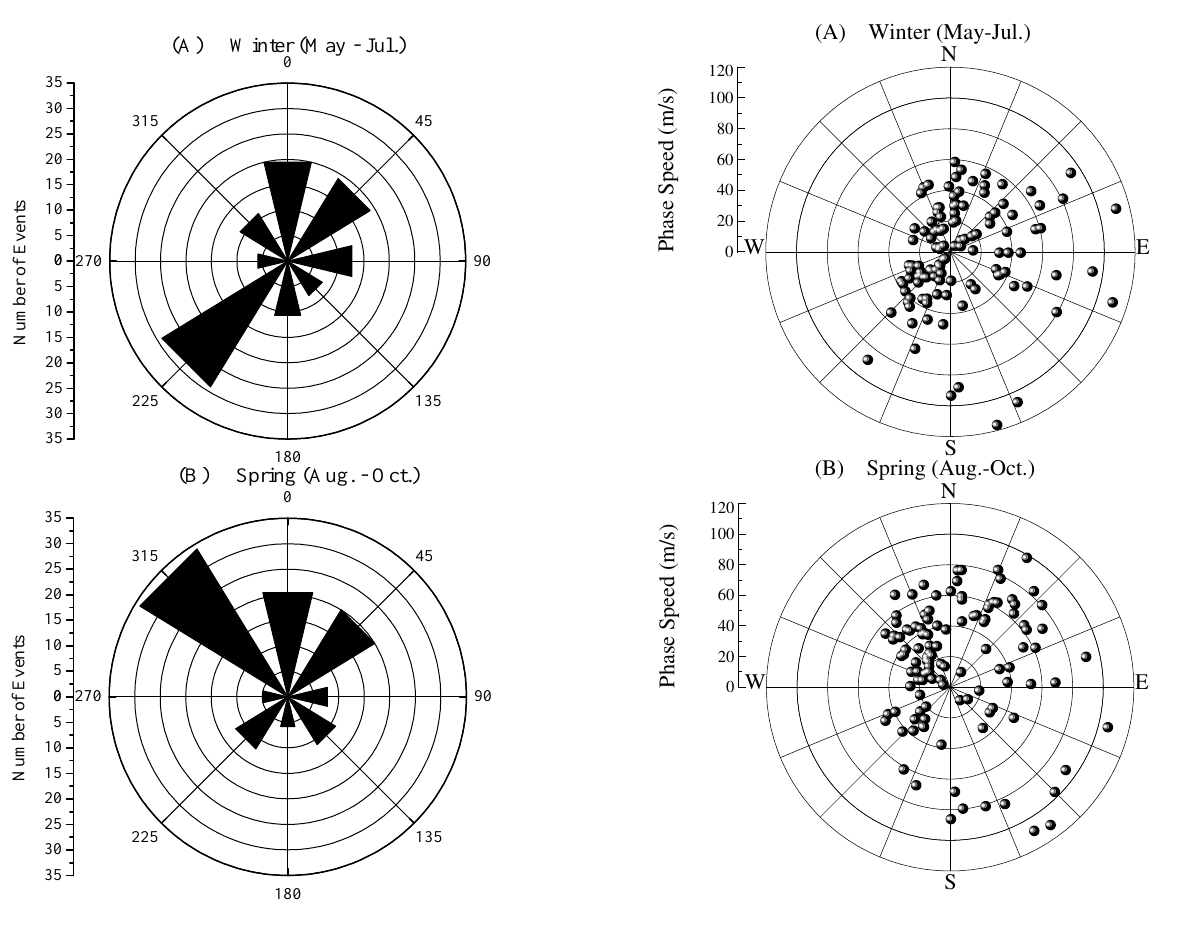
Fig. 4. Polar plots showing the seasonal variation for gravity wave propagation directions observed at CF.